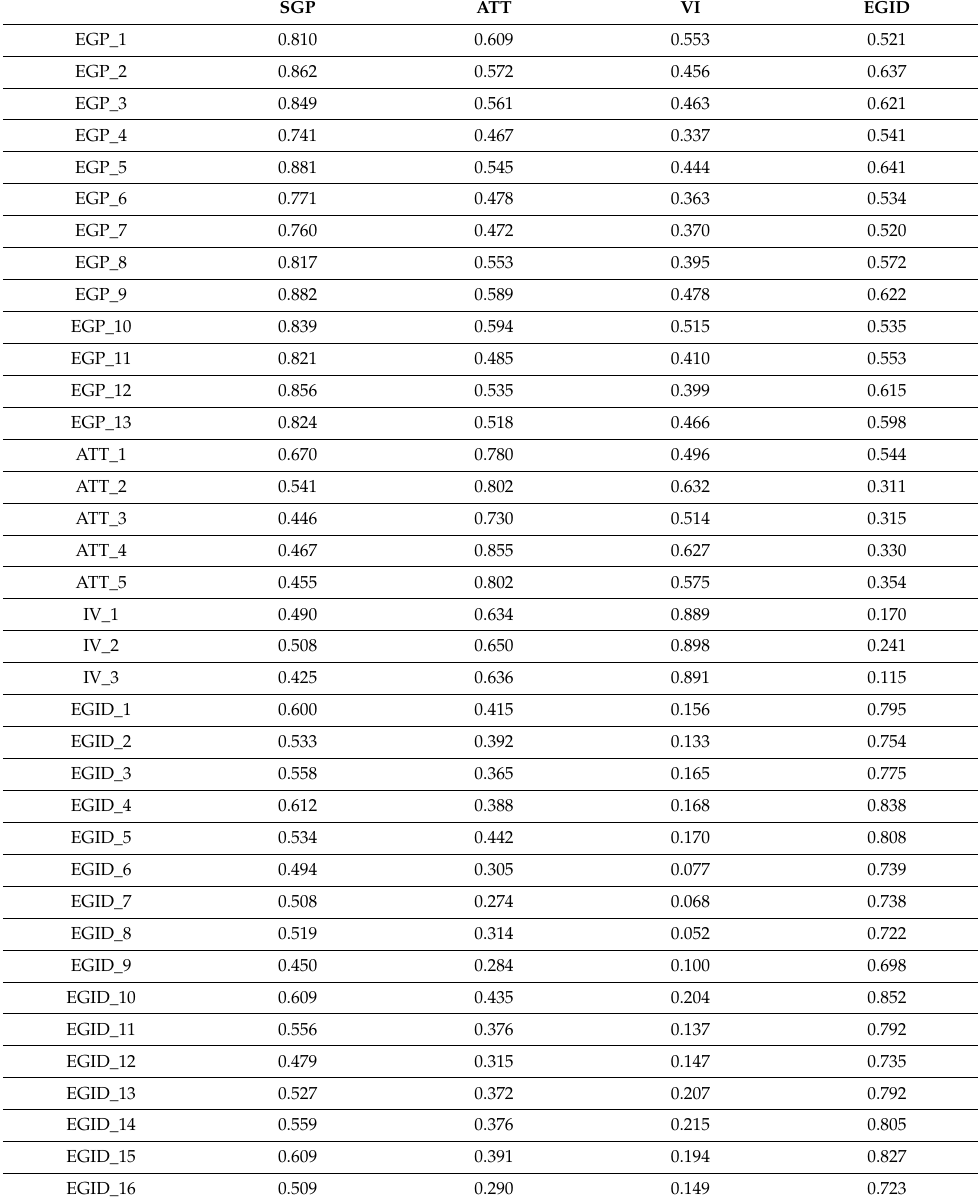
Table 2. Cross-loading